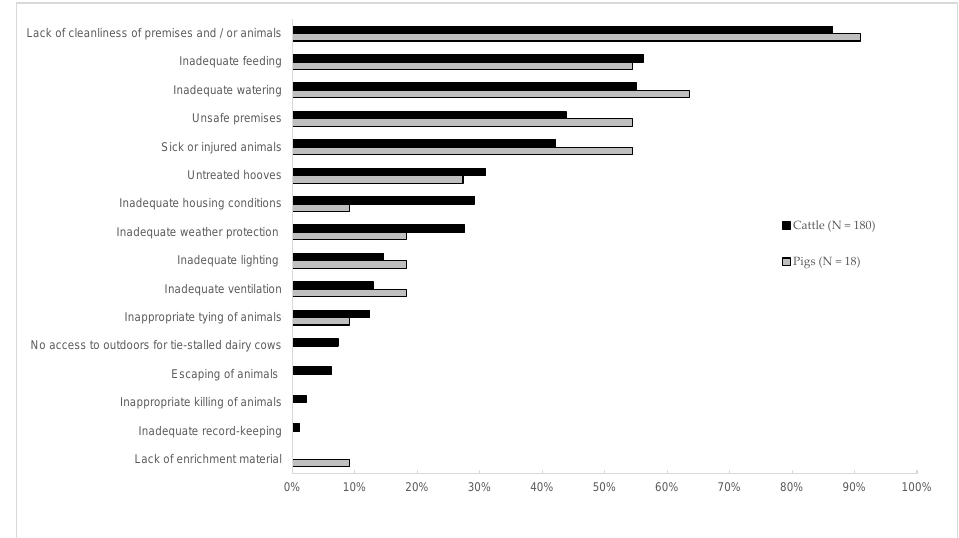
Figure 1. The proportion of different forms of animal welfare violations against cattle and pigs from all violations on the farm cases heard in the Finnish district courts during 2011–2016.